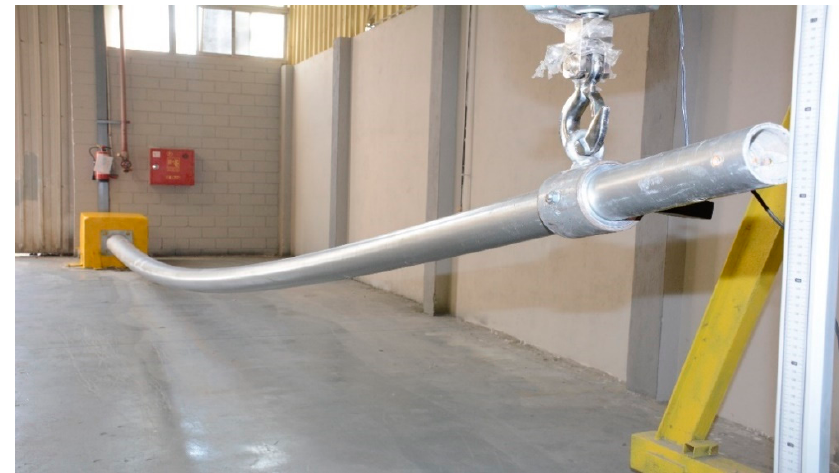
Figure 4. FRP pole.